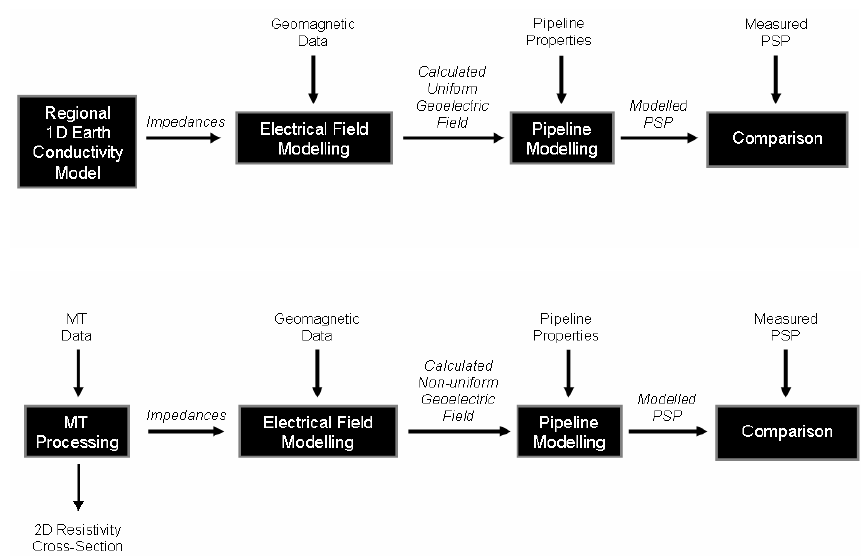
Fig. 1. Two schemes of PSP modelling. The bottom scheme takes into account the non-uniform (2-dimensional) geological conductivity variations along the pipeline